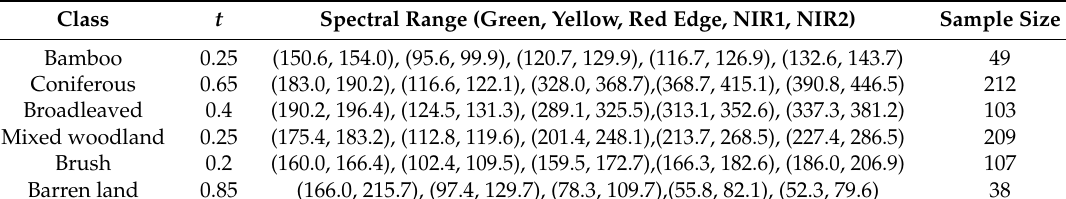
Table 3. The parameters to control the spectral range and the numbers of expanded training data.